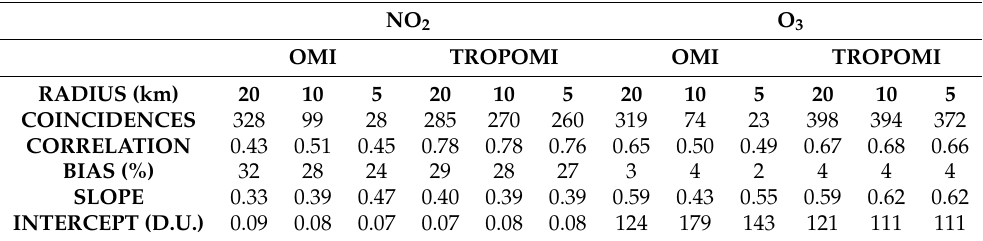
Table 3. Statistical parameters of the comparisons between ground-based DOAS and satellite VCDs for different spatial criteria for the selection of satellite data.